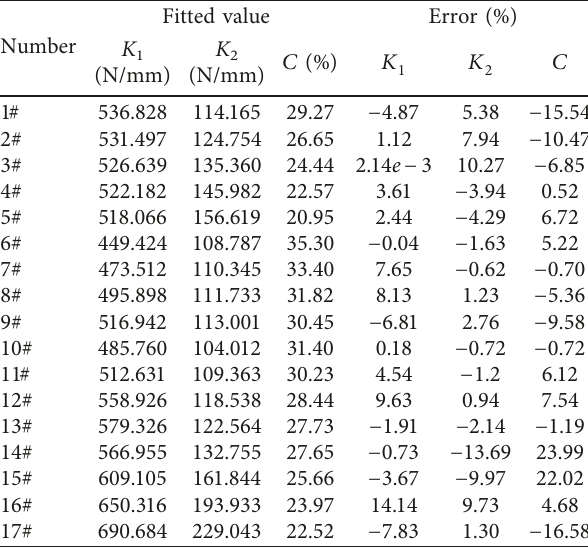
Table 8: The fitting error of the stiffness-damping of the WRI with different structural parameters.